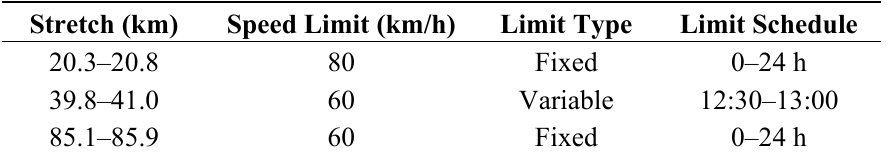
Table 3. Speed limits (below the generic road speed limit of 120 km/h).